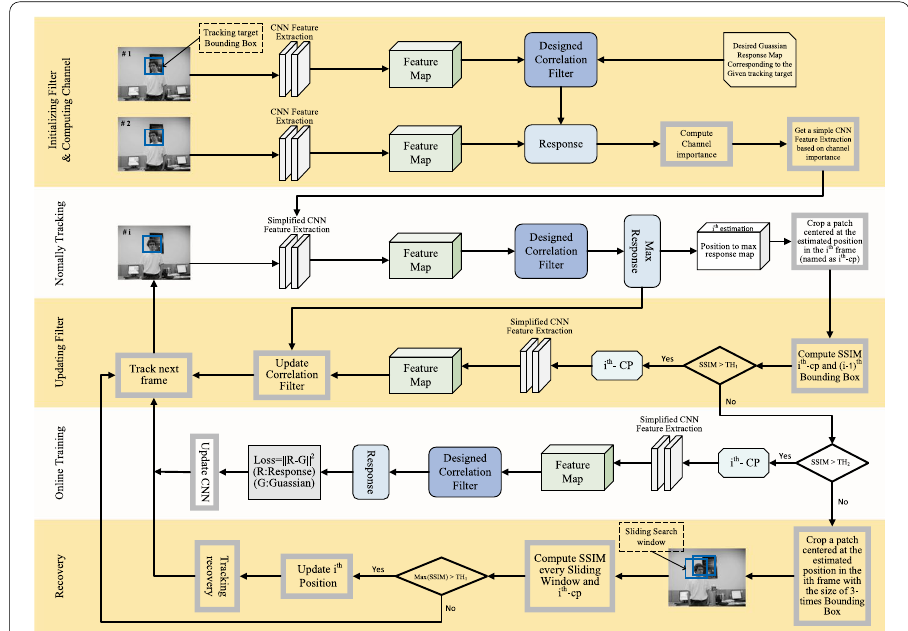
Fig. 1 The overall framework of deep correlation filter tracking based on channel